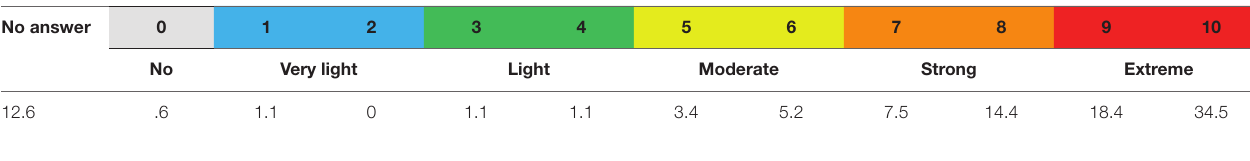
TABLE 2 | Estimation of symptom severity/burden in % ( N = 100 study